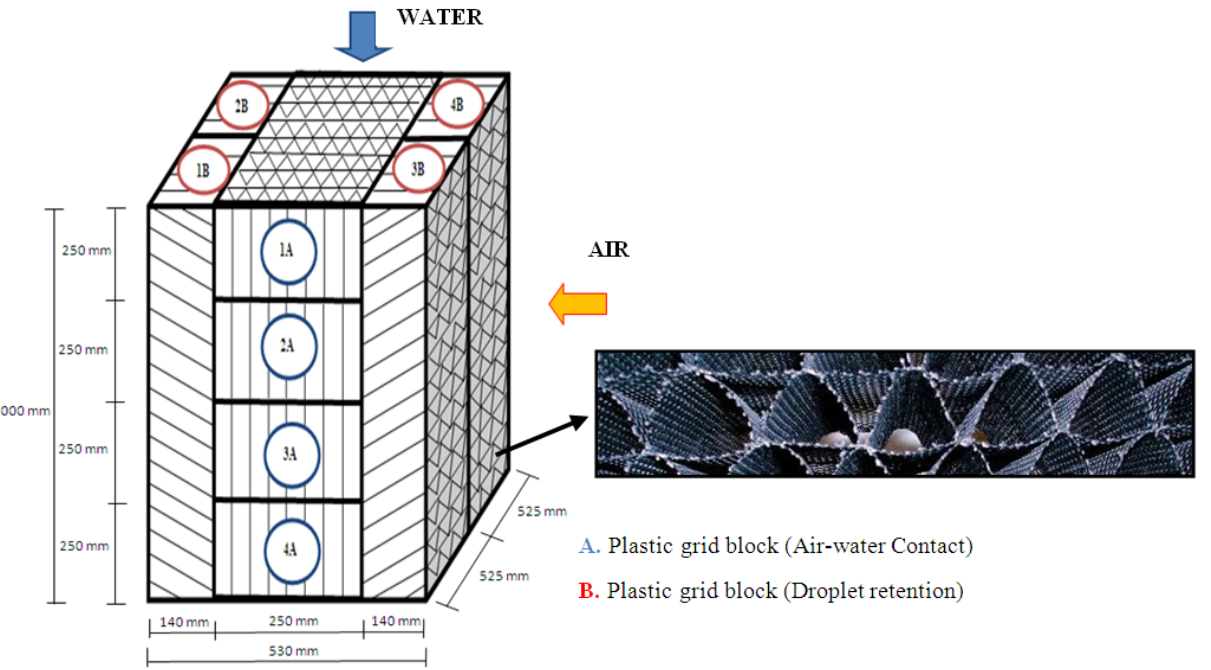
Figure 3. Characteristics and dimensions of the plastic